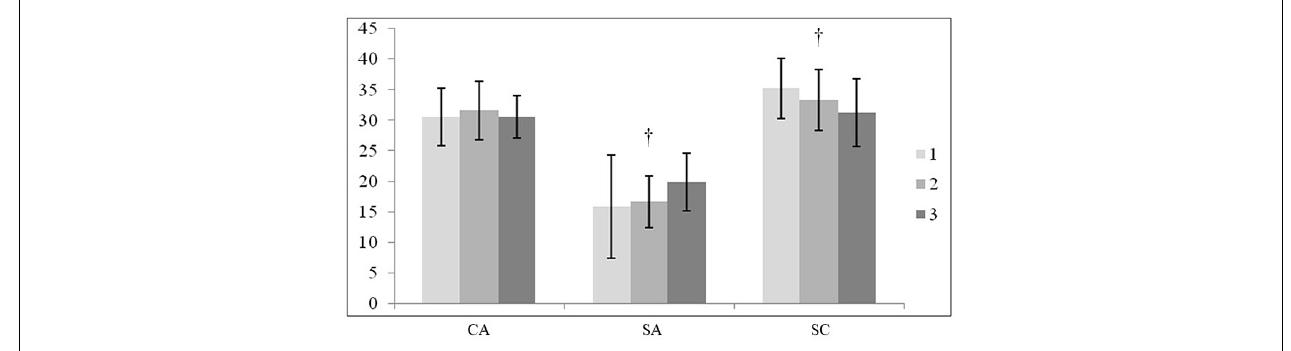
FIGURE 1 | Differences in the anxiety and self-confidence variables between the 3 game categories. † : Indicates differences between categories 1 and 3. 1: Category 1; 2: Category 2; 3: Category 3; CA, cognitive anxiety; SA, somatic anxiety; SC: self-confidence.